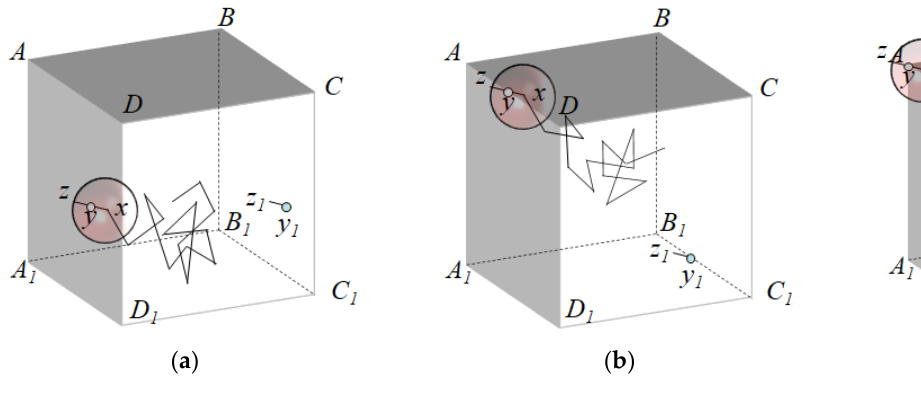
Figure 7. Periodic boundary conditions for Brown particles in the vicinity of the boundary: ( a ) face, ( b ) edge, and ( c ) vertex. ( b ) edge, and ( c ) vertex.